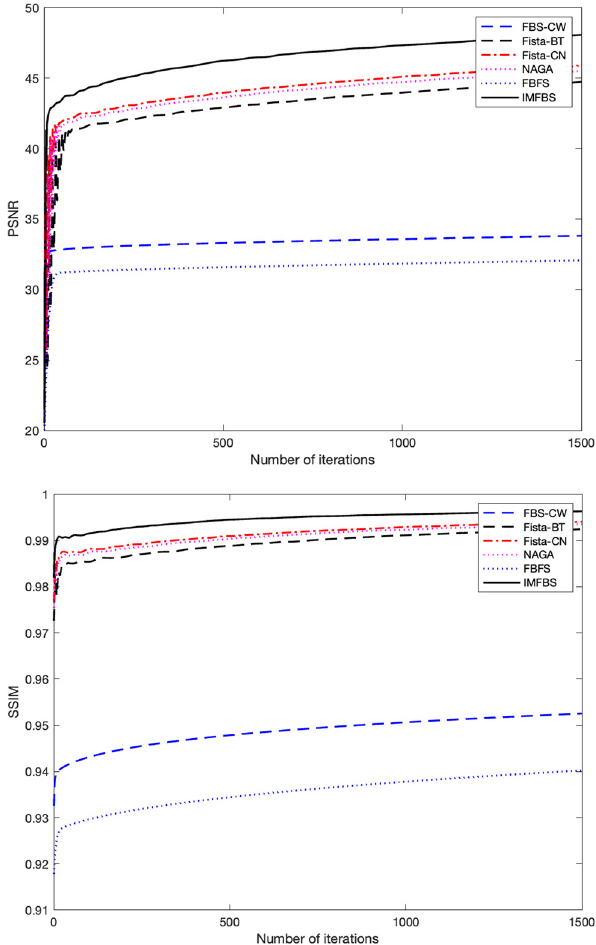
Figure 8: Graphs of PSNR and SSIM for Fig ( B ) by motion blurring,